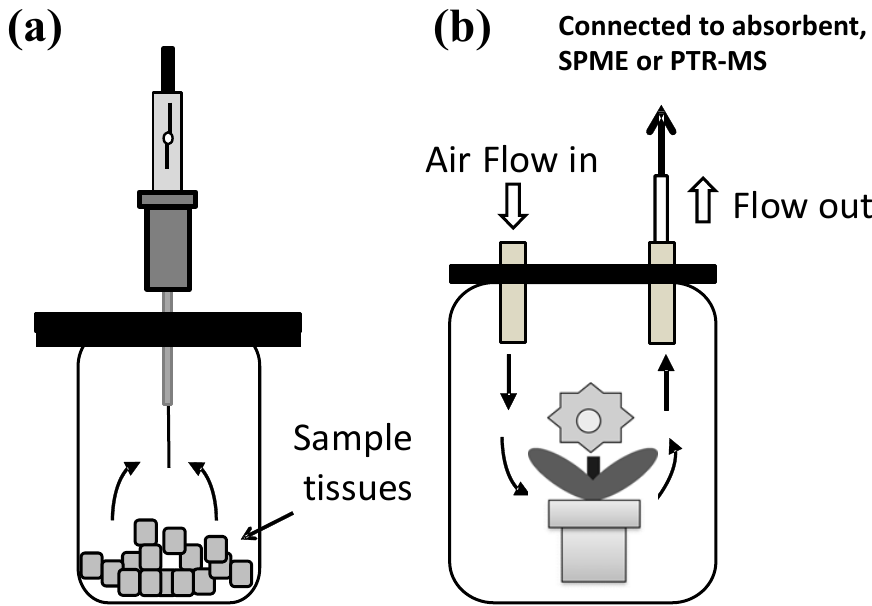
Figure 1. Typical headspace gas sampling systems. ( a ) Static headspace gas sampling